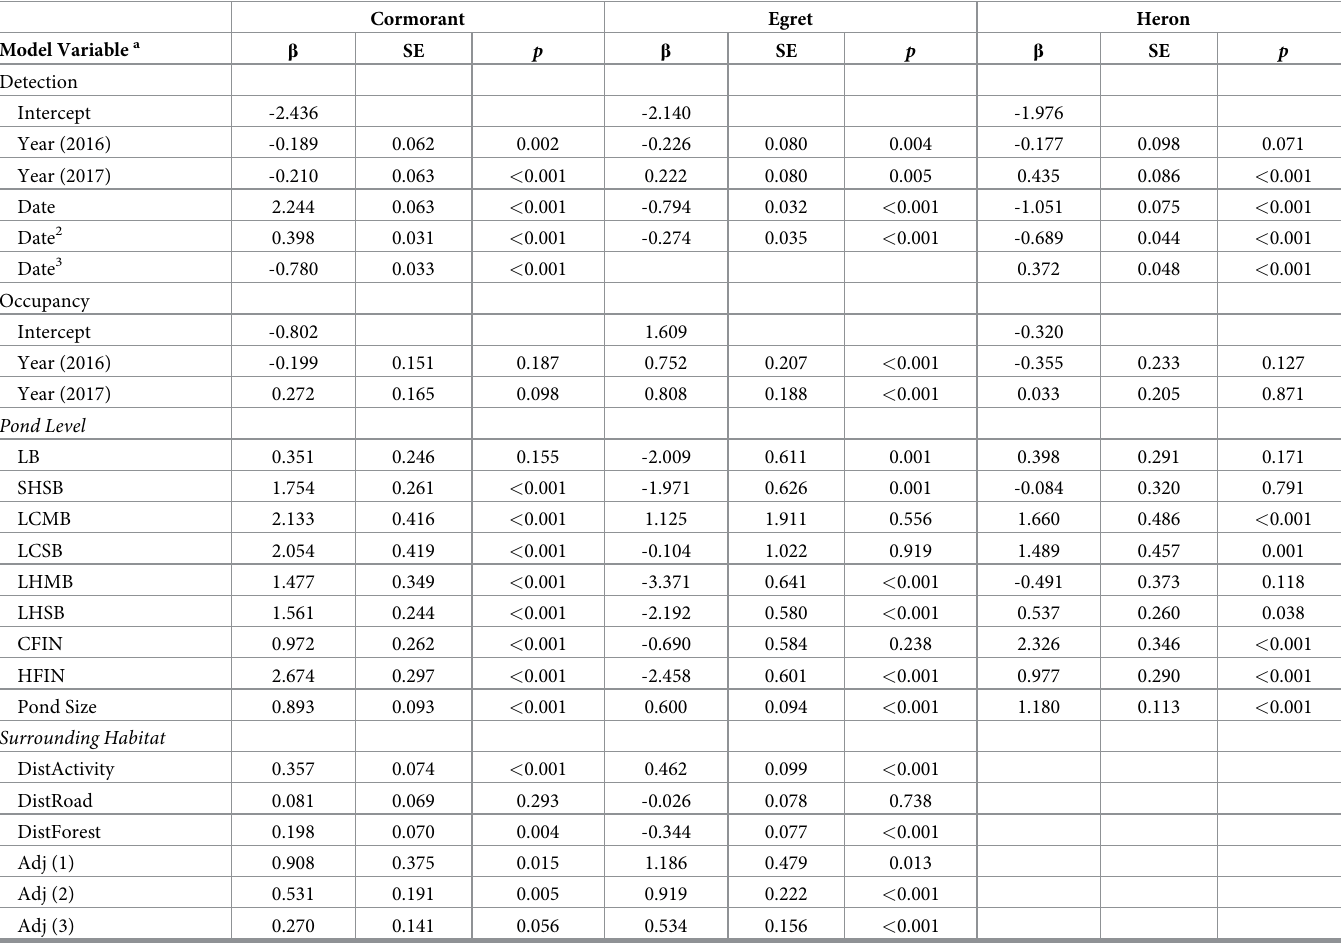
Table 3. Model parameter estimates for occupancy and detection for cormorants, egrets, and herons of catfish ponds in the Mississippi Delta. Parameter estimate, standard error, and p-values are shown. Models were constructed using data collected of species presence and absence on catfish ponds in the Mississippi Delta. N = 2,883 ponds for each